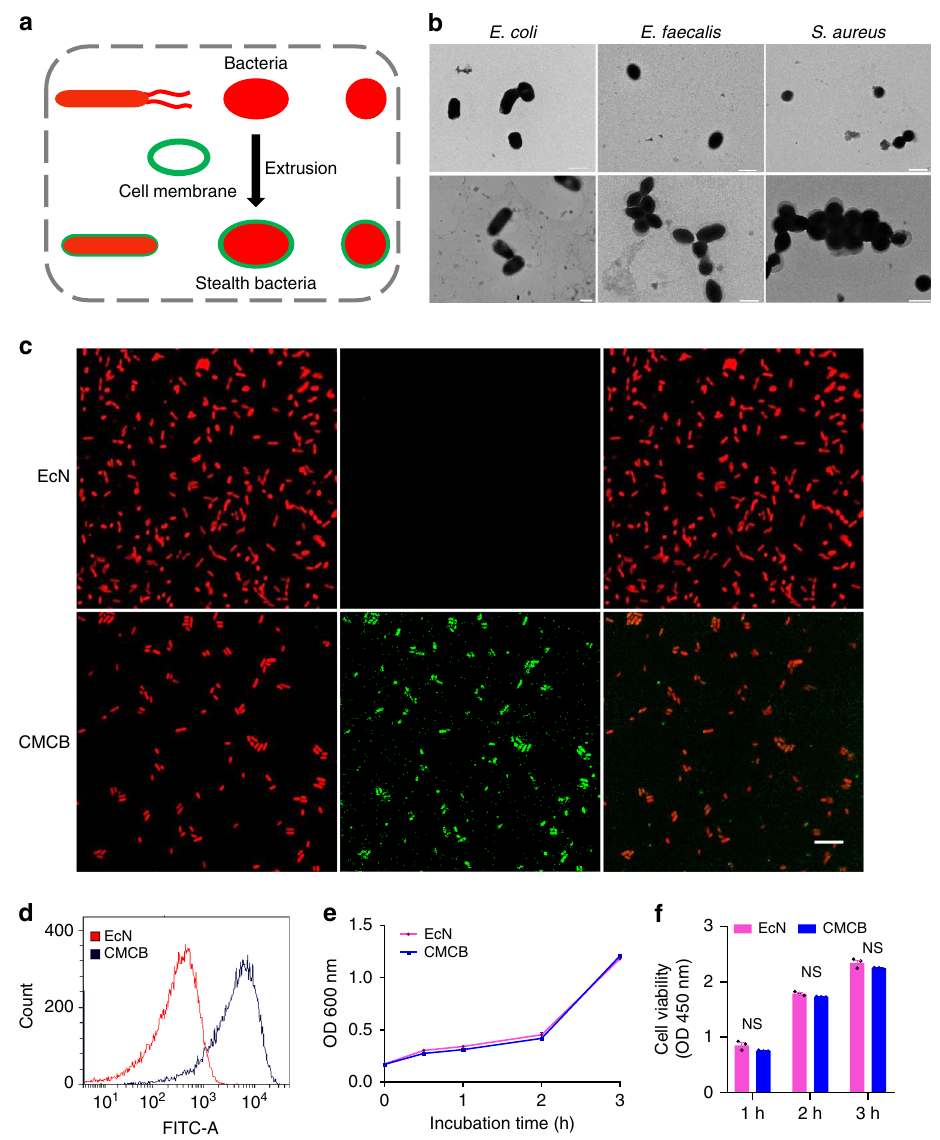
Fig. 1 Preparation and characterization of CMCB. a Schematic illustration for the preparation of CMCB by extruding bacteria with cell membranes. b Representative TEM images of uncoated bacteria and CMCB. Scale bar, 1 μ m. c LSCM images of EcN and CMCB. The red channel shows EcN producing mCherry, the green channel shows cell membranes conjugated with FITC-af fi nity anti-CD47-antibody, and the merge (orange) shows CMCB. Left mCherry, Middle FITC, Right merge. Scale bar, 10 μ m. d Flow cytometric analysis of EcN and CMCB. e Growth curves of EcN and CMCB. Bacteria were cultured in LB medium at 37 °C and OD 600 was measured at the indicated time points. f Bacterial viability analysis of EcN and CMCB by CCK-8 assays. Bacteria were incubated at 37 °C and viability was monitored by measuring OD 450 at 1 h intervals. Error bars represent the standard deviation ( n = 3). NS no signi fi